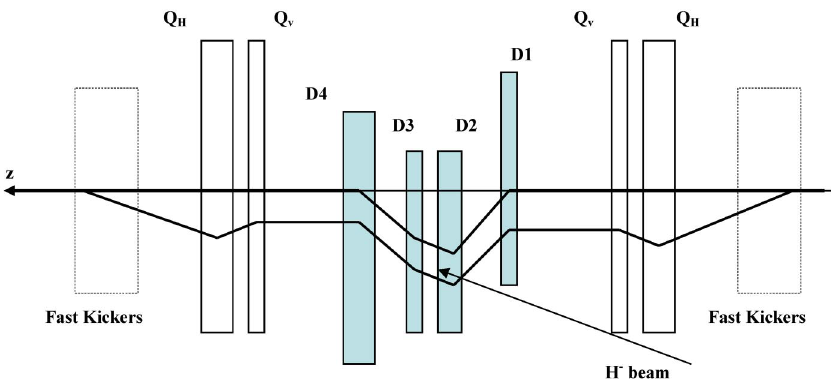
FIG. 1. (Color) Injection straight in the SNS